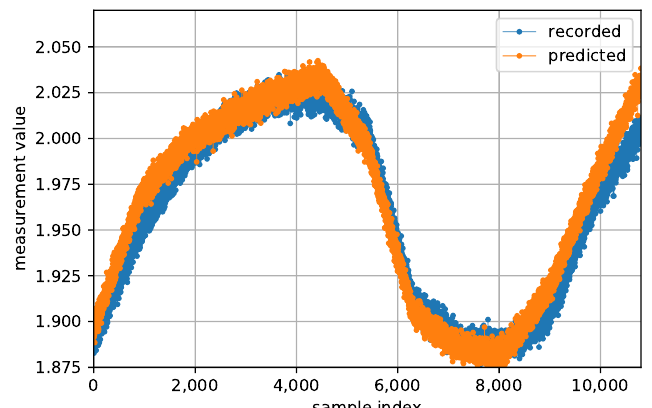
Figure 1. An example for ML-predicted measurement vs. recorded measurement value